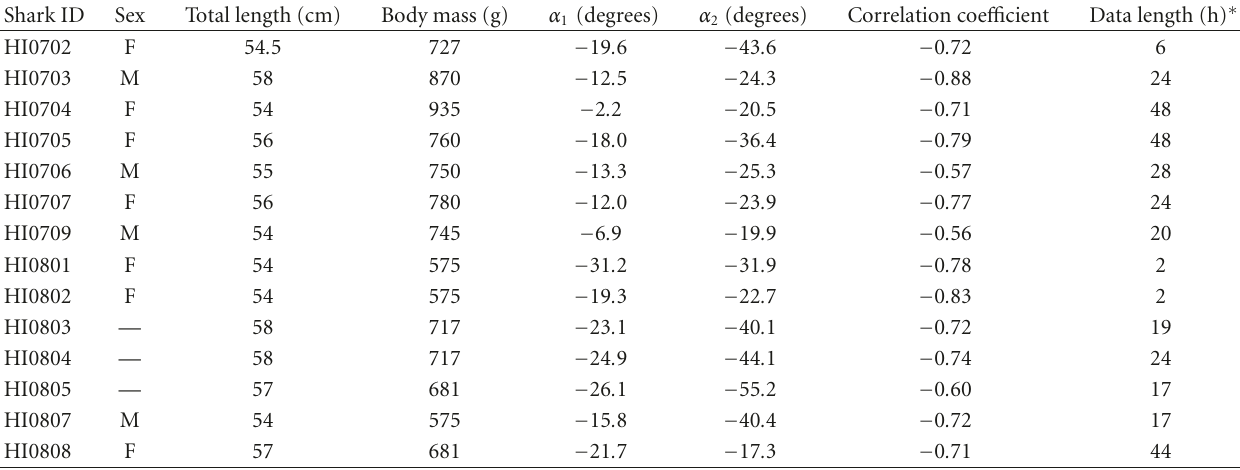
Table 1: Morphological information and attachment angles of loggers derived from a previous method ( α 1 ) and that following adjustment by a new method ( α 2 ) for each shark.